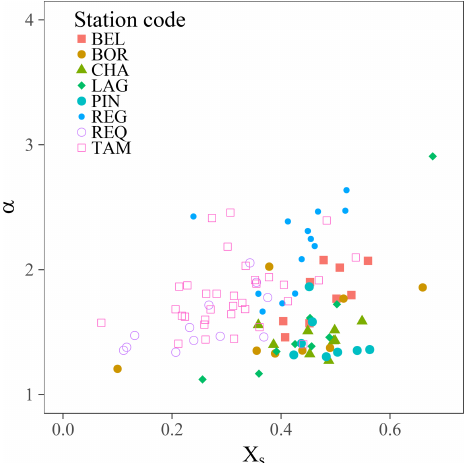
Figure 3. Observed ratios α = (cid:104) C (cid:105) /C ( h ) of the total mean concen- tration to the total index concentration sampled at the water surface vs. the sand mass fraction X s